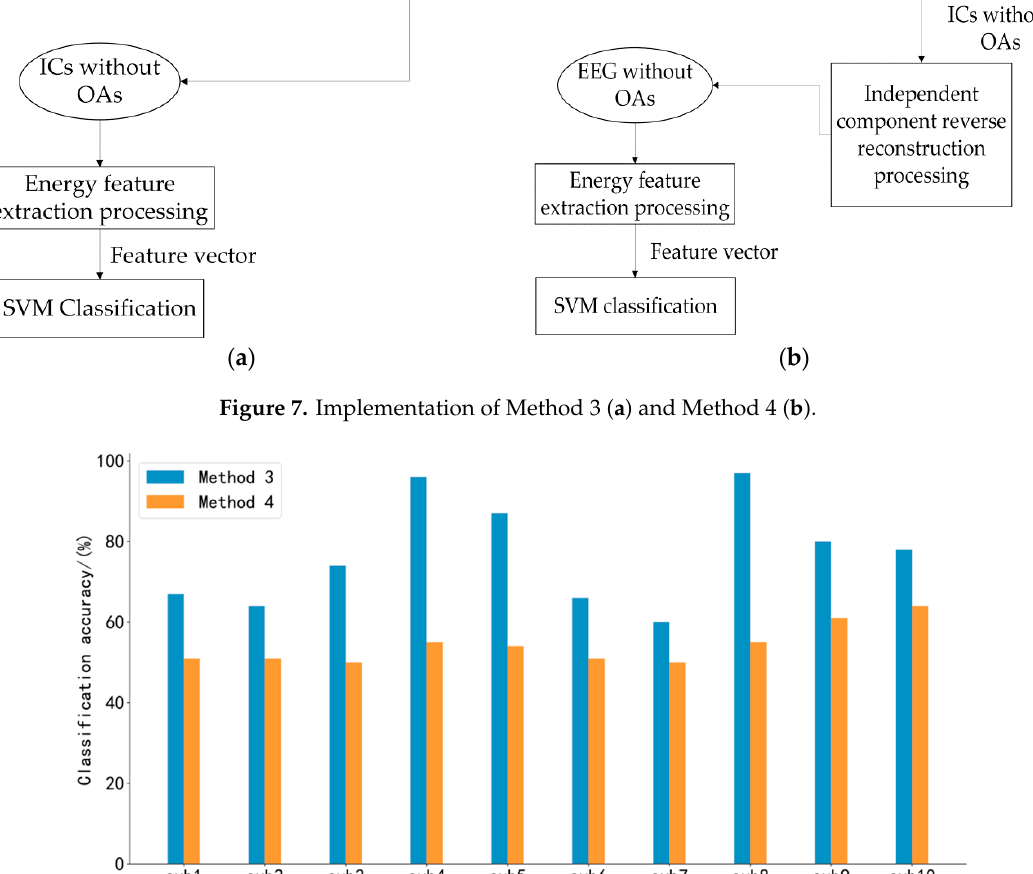
Figure 8. Classification accuracy comparison of Method 3 and Method 4.